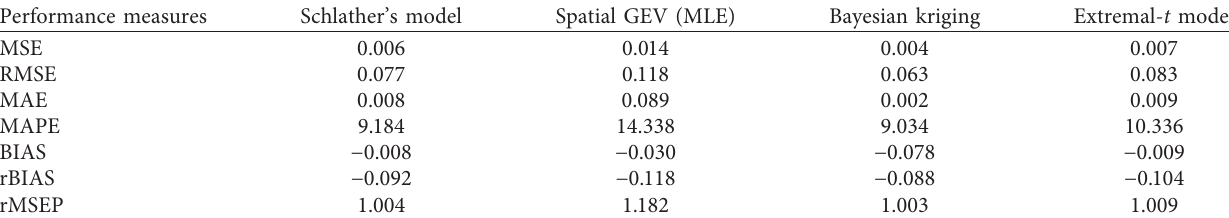
Table 6: Predictive performance measures of various models using 5 years’ return level as observed maximum ozone